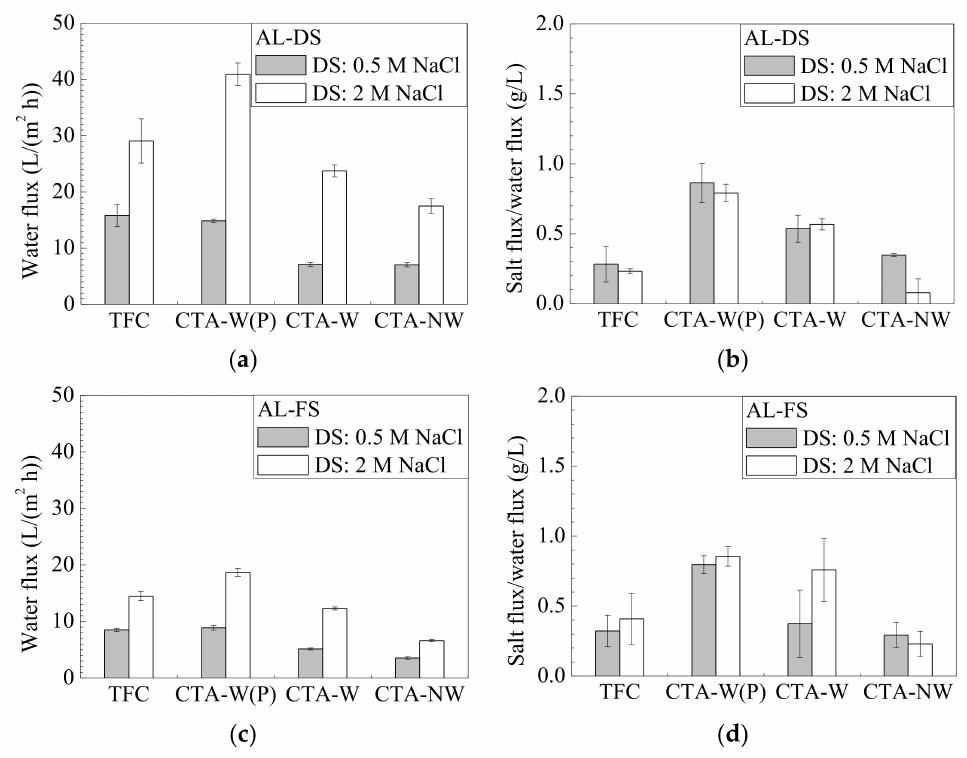
Figure A3. FO water flux and salt flux/water flux of the TFC, CTA-W(P), CTA-W, and CTA-NW membranes. Testing conditions: 10 mM NaCl as FS, and 0.5 M or 2 M NaCl as